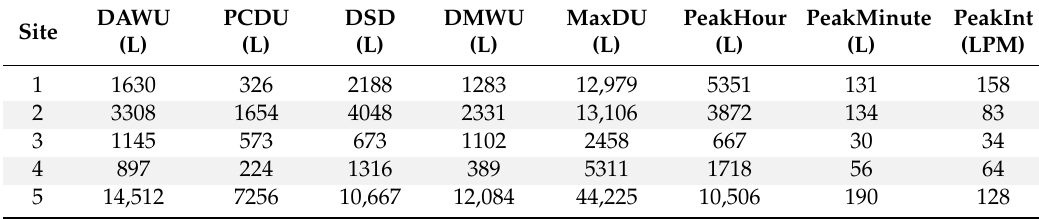
Table 10. Water usage statistics calculated from the data